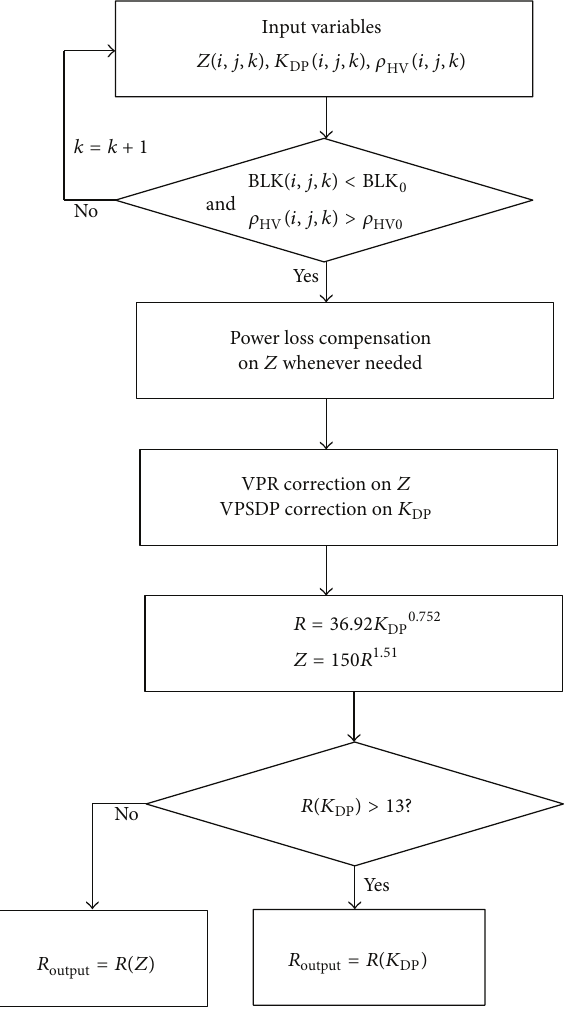
Figure 6: The block diagram of the vertical corrected composite